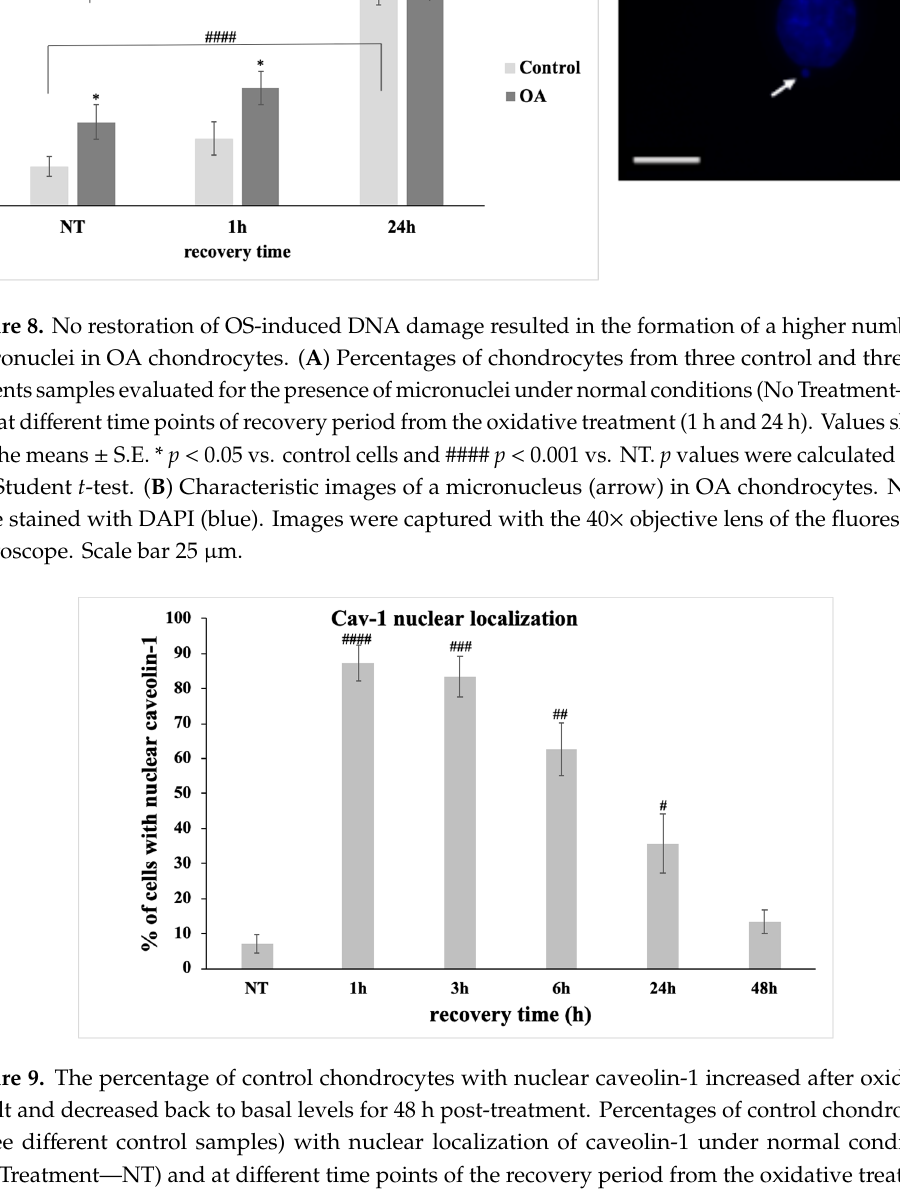
Figure 8. No restoration of OS-induced DNA damage resulted in the formation of a higher number of micronuclei in OA chondrocytes. ( A ) Percentages of chondrocytes from three control and three OA patients samples evaluated for the presence of micronuclei under normal conditions (No Treatment- NT) and at different time points of recovery period from the oxidative treatment (1 h and 24 h). Values shown are the means ± S.E. * p < 0.05 versus control cells and #### p < 0.001 versus NT. p values were calculated using the Student t -test. ( B ) Characteristic images of a micronucleus (arrow) in OA chondrocytes. Nuclei were stained with DAPI (blue). Images were captured with the 40× objective lens of the fluorescence microscope. Scale bar 25 μ m.